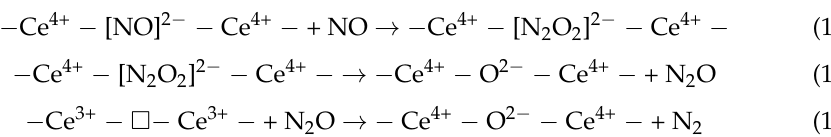
Table 2. Reaction data obtained during NO reduction reaction for pre-reduced Ba6/Cu2CZ and Cu2/CZ. NO Reduction (50 or 250 ◦